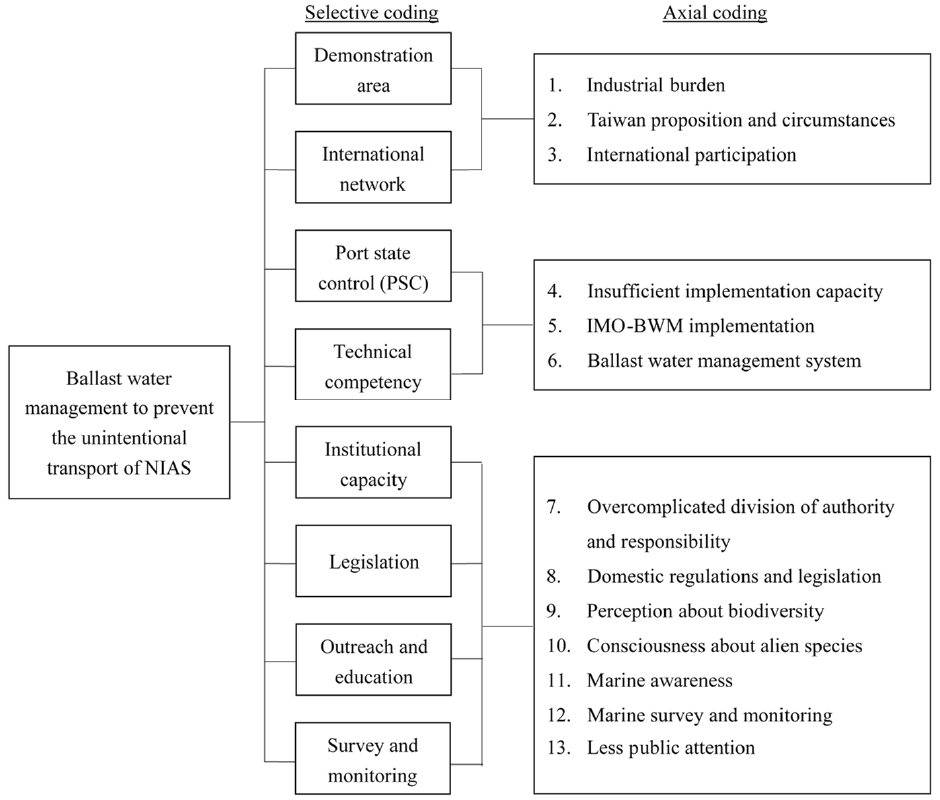
Figure 1. Themes regarding the stakeholders’ perceptions of BWM.